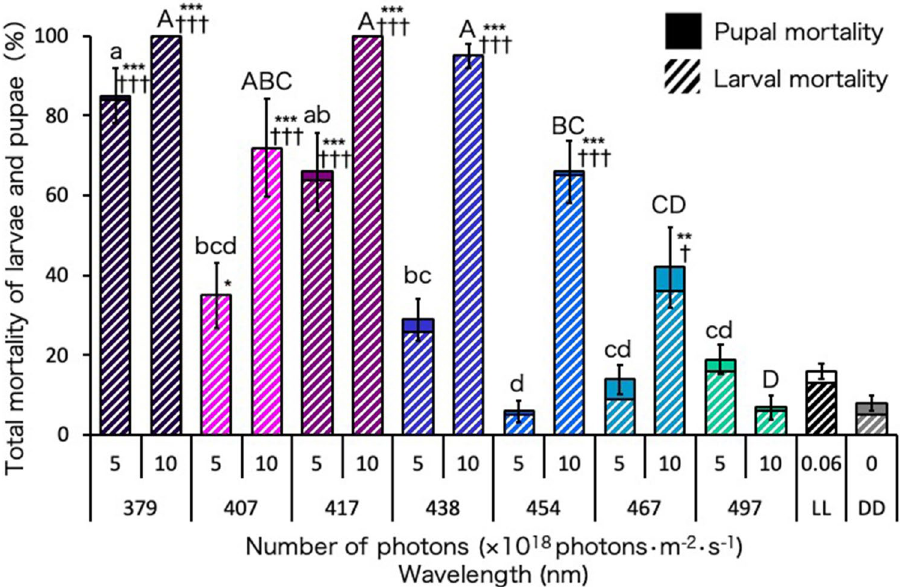
Figure 2. Mortality of Aedes albopictus irradiated with blue light during the larval to pupal stages. Data represent the means ± standard errors. Asterisks above the bars indicate significant differences between the treatments (UVA and blue light irradiation) and control [dark condition (DD)] (Steel test: * p < 0.05, ** p < 0.01, *** p < 0.001). Daggers above the bars indicate significant differences between the treatments (UVA and blue light irradiation) and the control [continuous white light condition (LL)] (Steel test: † p < 0.05, ††† p < 0.001). Bars with the same letters are not significantly different (Steel–Dwass test, p > 0.05). Ten replications (10 larvae per replicate) were